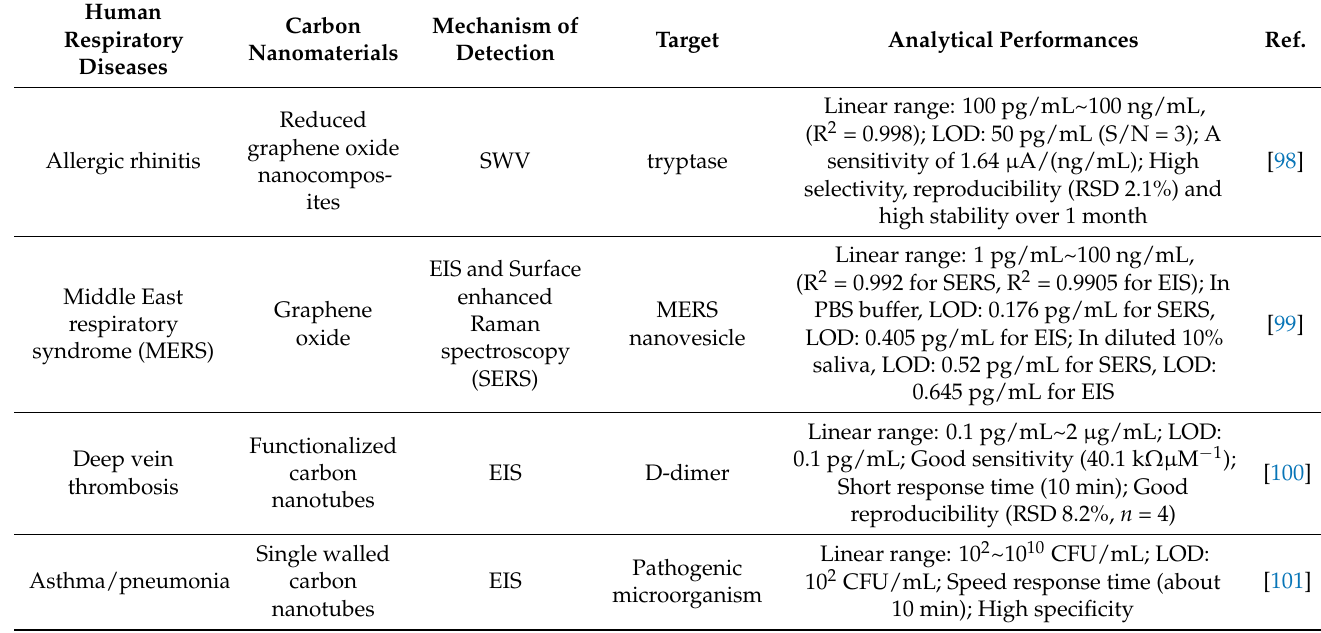
Table 6. Other electrochemical biosensors based on carbon nanomaterials for human respiratory diseases diagnosis.